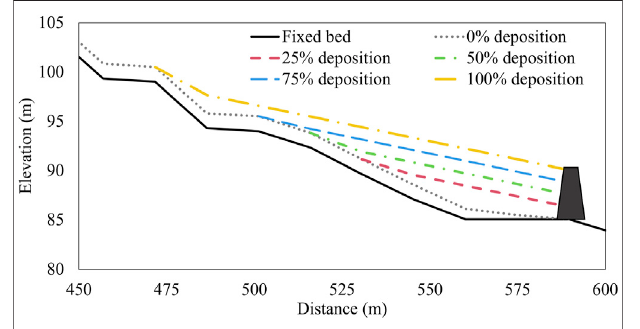
FIGURE4| Changesinthegradientoftheupstream reachesofthedam according to the deposit scenario. The location of the check dam is represented as a black trapezoid.